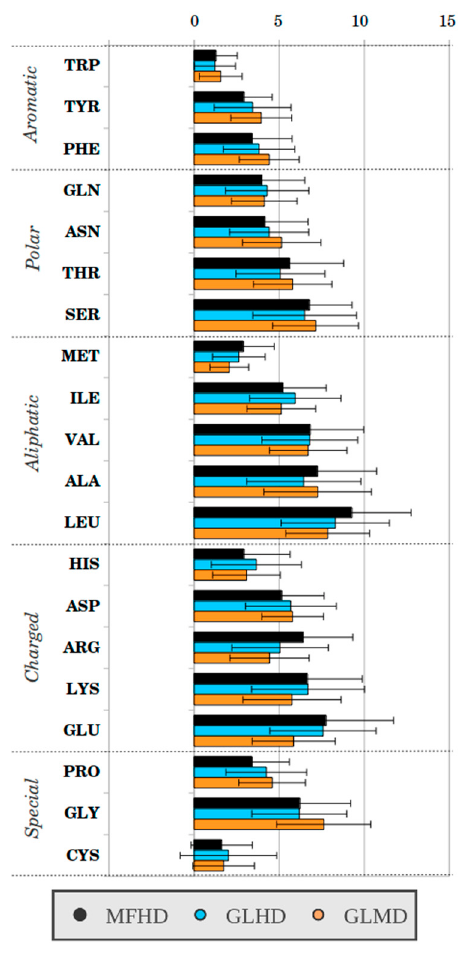
Figure 3. Sequence properties of MFHD, GLHD, and GLMD proteins (For values, see Table S2). We investigated the MFHD with several protein disorder predictors (IUPred, ESpritz, GlobPlot, VSL2b, MobiDB Lite, MetaDisorder) [8,22–26], which worked well on the IDPs listed in DIBS,